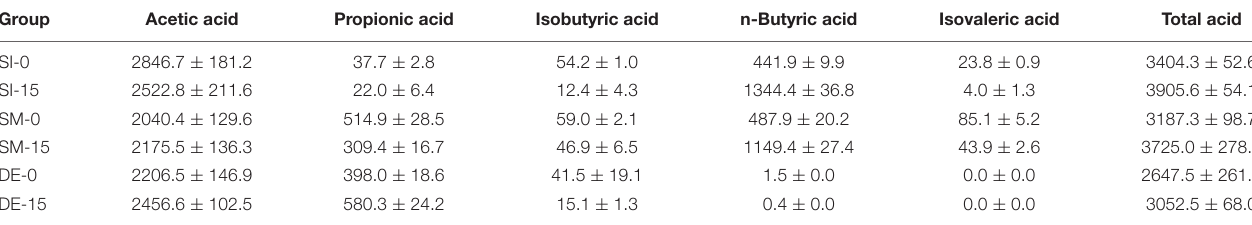
TABLE 4 | VFA composition and concentration of PW after microbial pretreatment of SI, SM, and DE*. Group Acetic acid Propionic acid Isobutyric acid n-Butyric acid Isovaleric